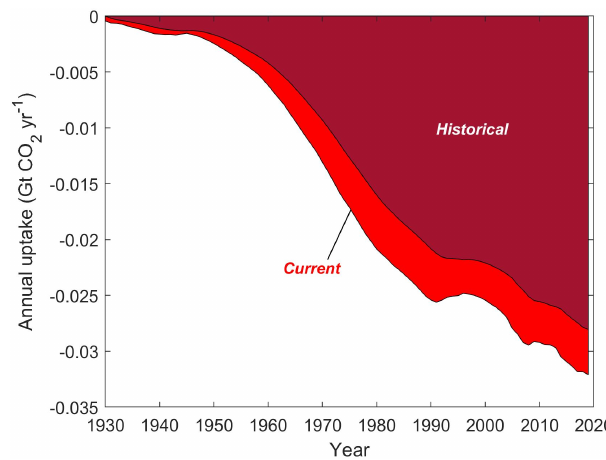
Figure 8. The median annual carbon uptake of concrete consumed in Europe and central Eurasia. Each year’s uptake is split between that associated with concrete consumed in prior years and in that